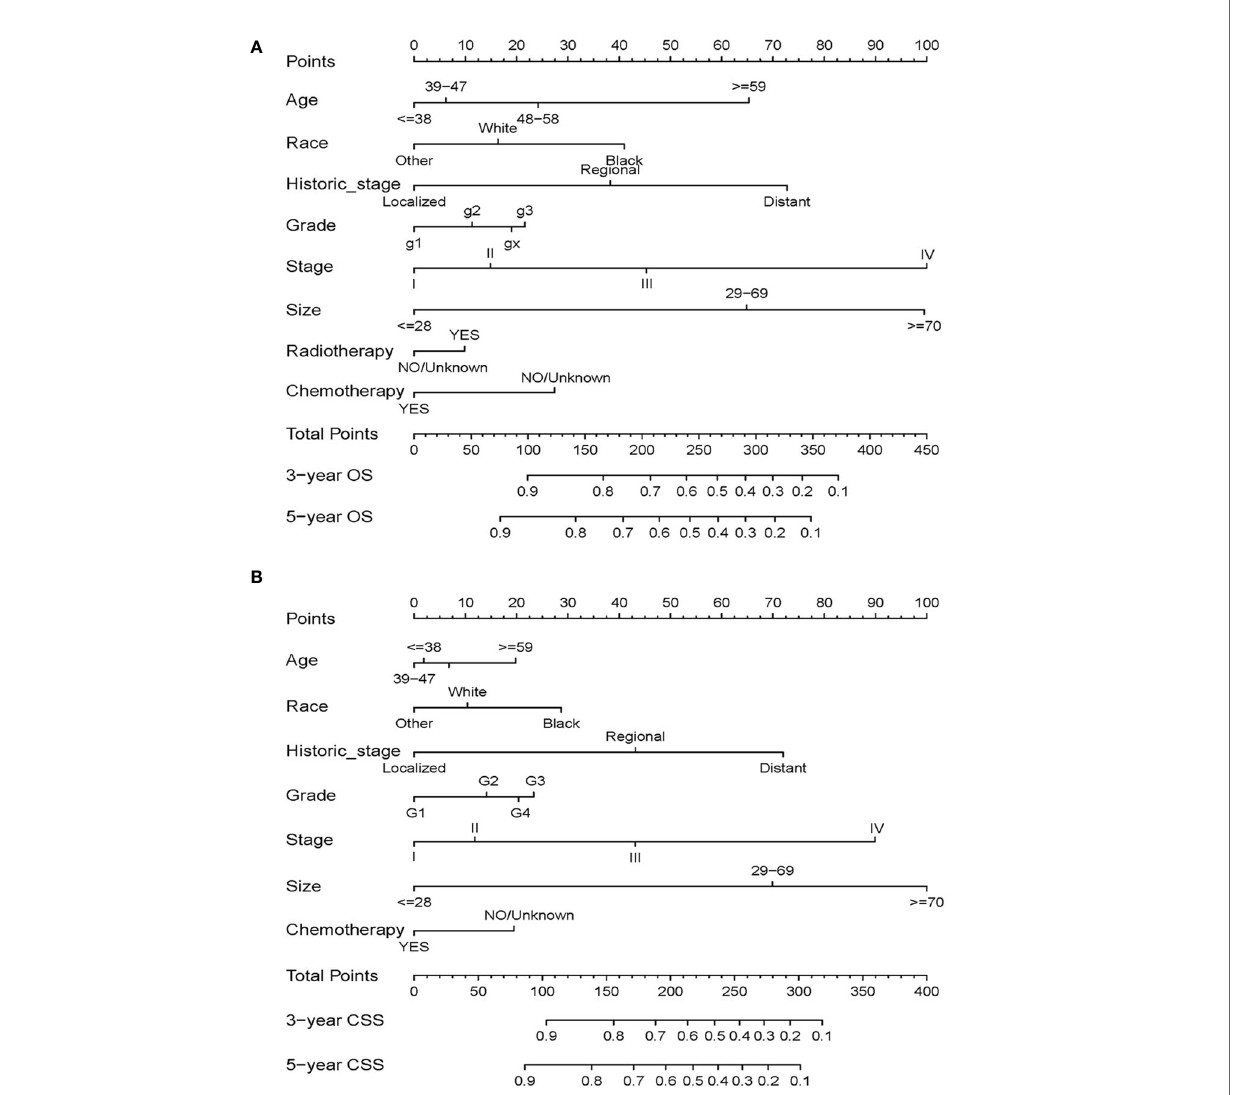
FIGURE 3 | Nomograms for predicting 3- and 5-year OS (A) and CSS (B) in patients with cervical squamous cell